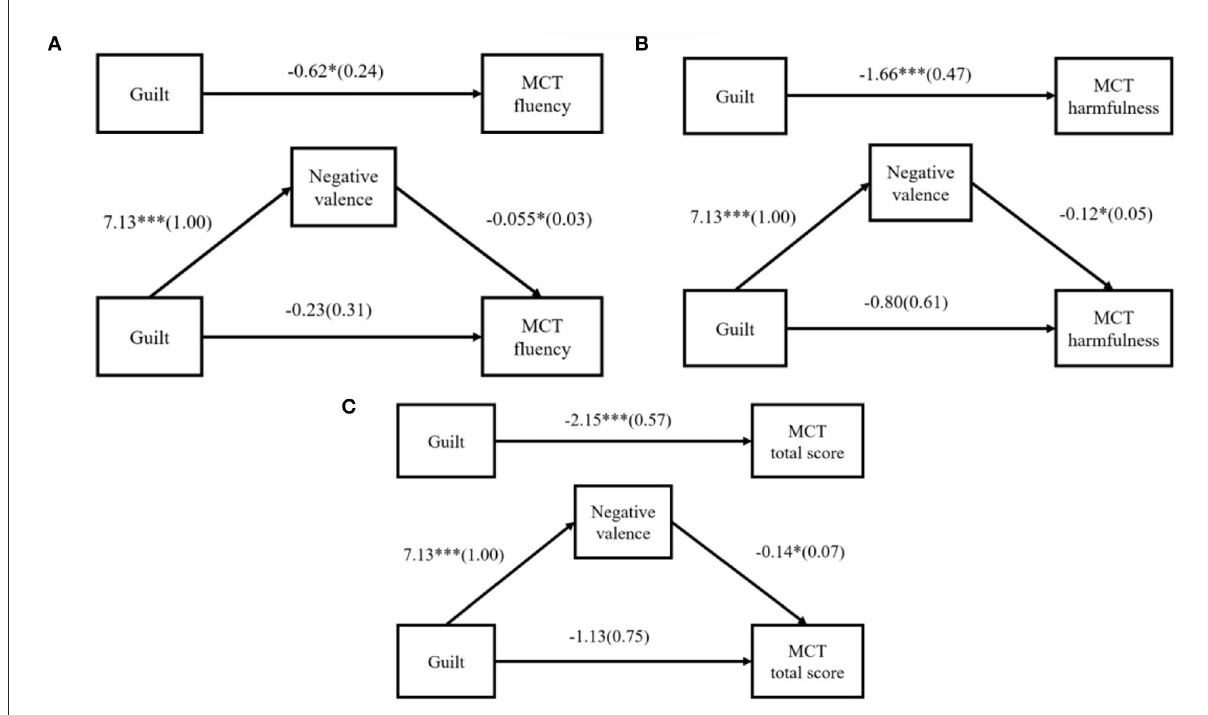
FIGURE3 (A–C) Mediation analysis using negative valence as the mediator. * p < 0.05, *** p < 0.001. The coefficient is non-standard coefficient, and the standard error is in